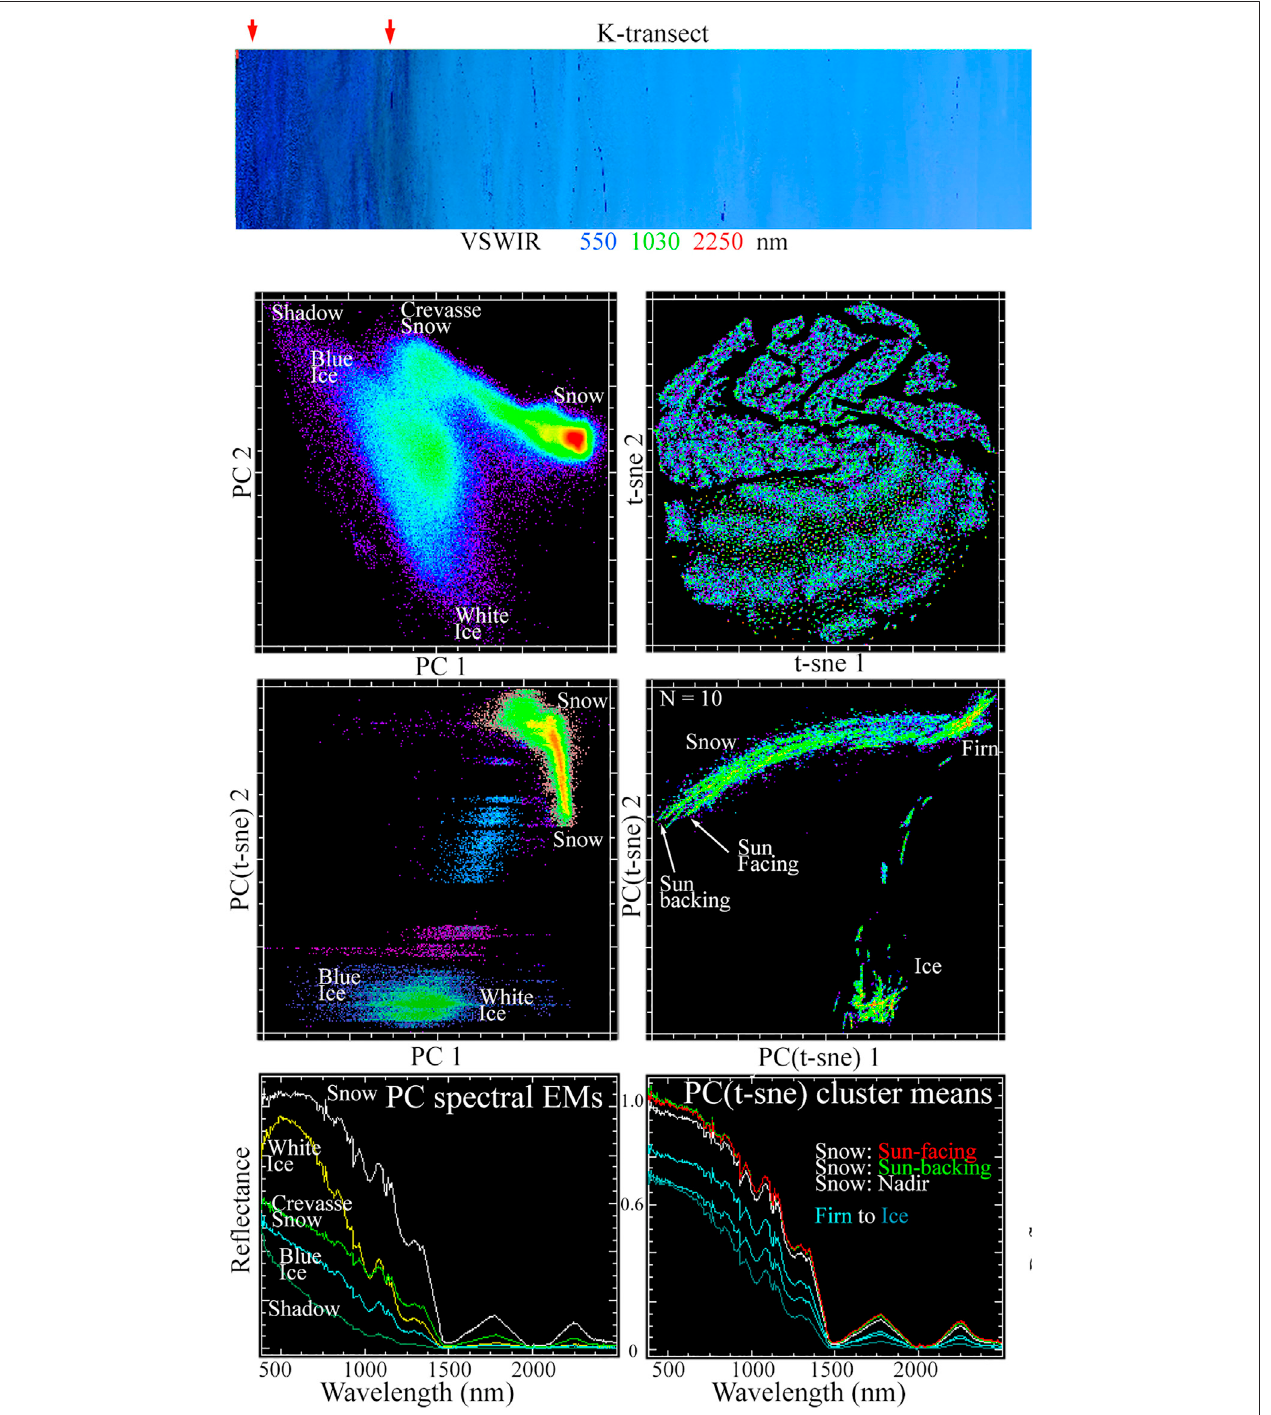
FIGURE 7 | Multiscale spectral feature spaces for the K transect line. The continuous PC feature space has distinct snow and ice continua, however the snow-ice continuum intersects the continuum spanning white and blue ice. The individual transect line ’ s continuous PC space occupies a subspace of the more continuous full composite space ( Figure 2 ), In contrast, the t-SNE space is dominated by a single large cluster corresponding to a snow- fi rn continuum and several smaller clusters correspondingto fi rn-icediscontinua.SeparableclustersarehighlightedinthePC+PC(t-SNE)spaces,withclustermeanspectrashowingthecontinuousvariation in spectral amplitude and curvature represented by the PC dimension. The snow on the K transect line clearly distinguishes the sun-facing and sun-backing sides of the swathinthe PC(t-SNE) space-eventhough theamplitudedifferences contribute toolittlevariance tobedistinguishedinthe PCspace.Thecompressed lengthAVIRIS- NG image (top) show locations (arrows) of full resolution examples in Figures 8 , 9 .